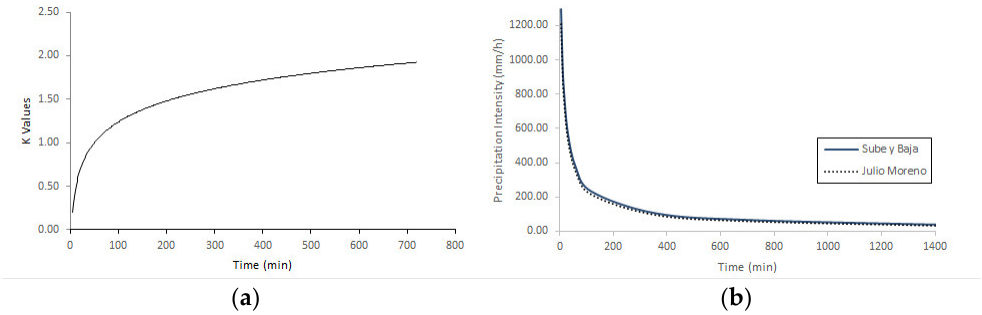
Figure A1. ( a ) K values vs. time chart, ( b ) IDF curves for PMP of Sube y Baja and Julio Moreno stations.